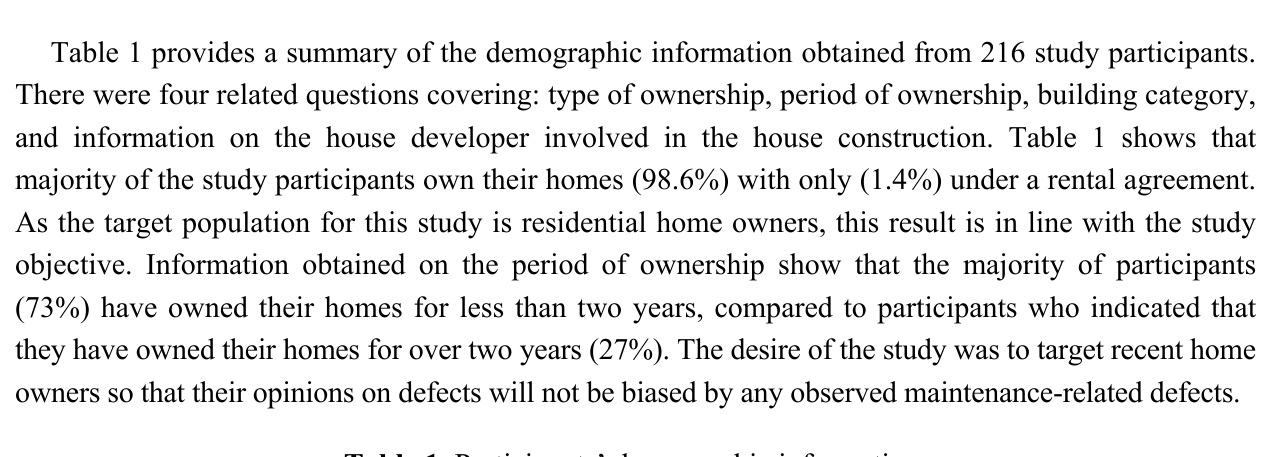
Table 1. Participants’ demographic